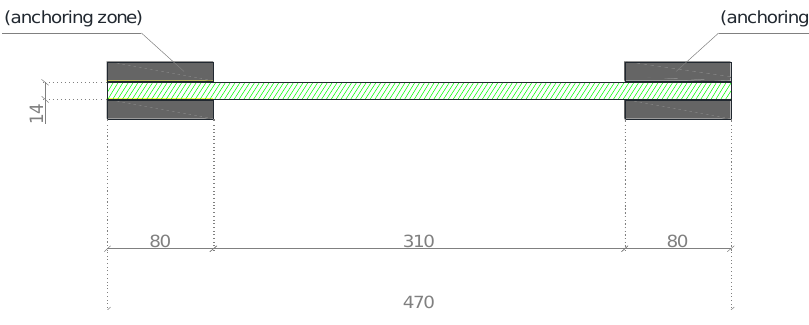
Figure 4. GFRP samples (side view).